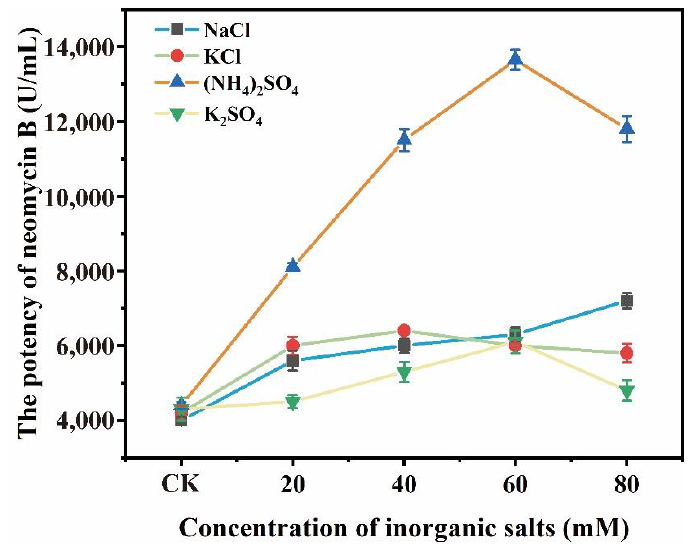
Figure 1. The effects of different inorganic salts on the biosynthesis of neomycin B.